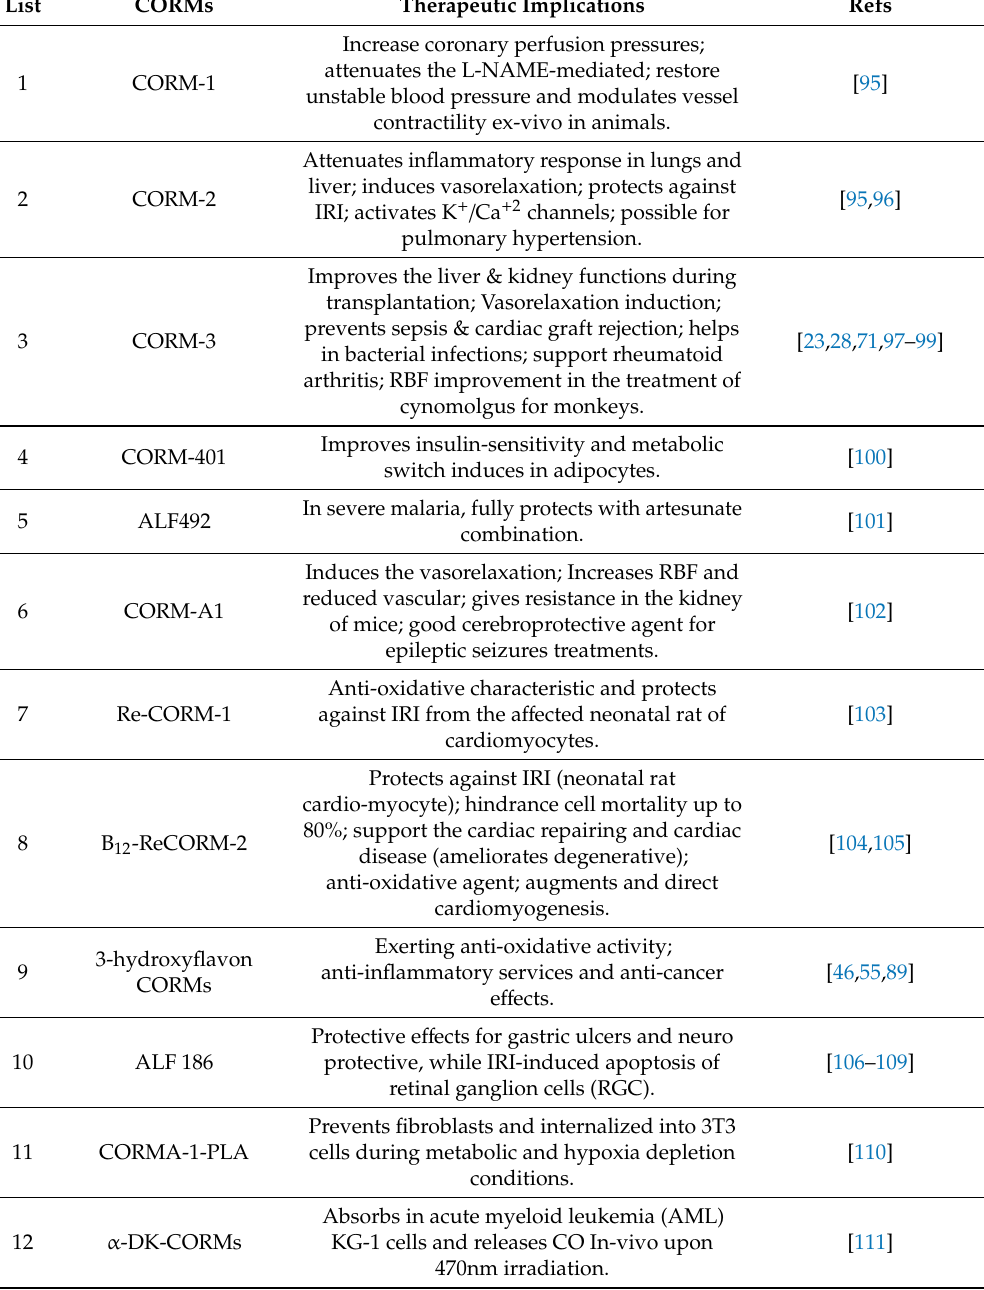
Table 1. Nonmetallic and organometallics CO-releasing molecules (CORM’s) fragments exhibited therapeutics